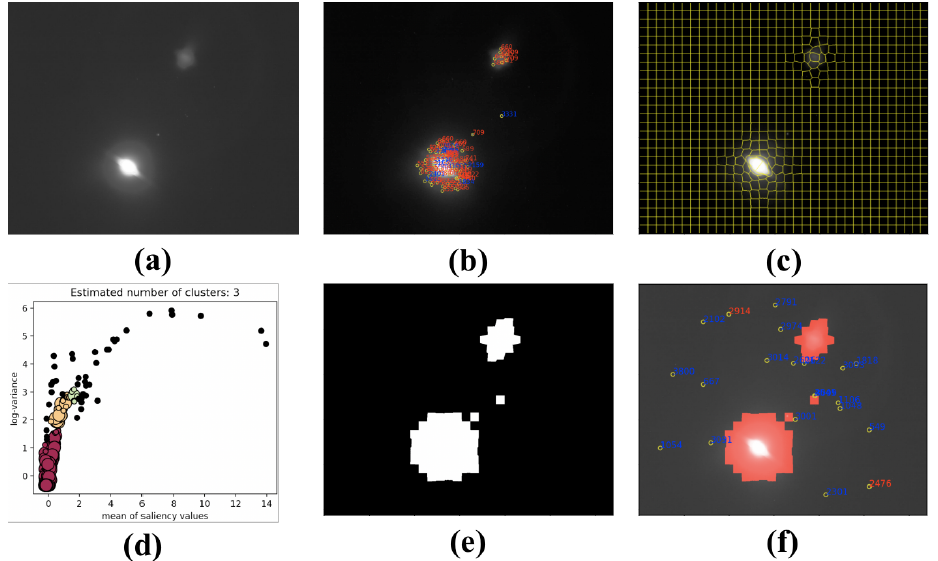
Figure 20. Irregular shaped interference with moonlight in the star tracker: ( a ) the star image with moonlight; ( b ) the extraction result with W-LOF algorithm (there are many false star spots); ( c ) the result of SLIC segmentation; ( d ) the result of DBSCAN clustering; ( e ) binary mask generated by proposed method; and ( f ) the result of star spot extraction only in the sky